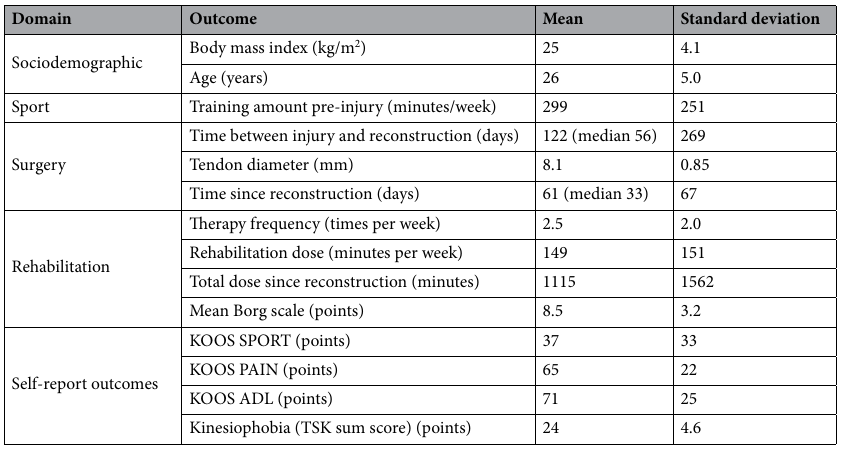
Table 2. Mean (median, where urgent) and standard deviations of all interval (and pseudo interval) scaled sociodemographic, sport-, injury-, surgery- and rehabilitation measures, including specific characteristics as well as the self-report functional outcomes of the study sample, TSK Tampa Scale of Kinesiophobia.